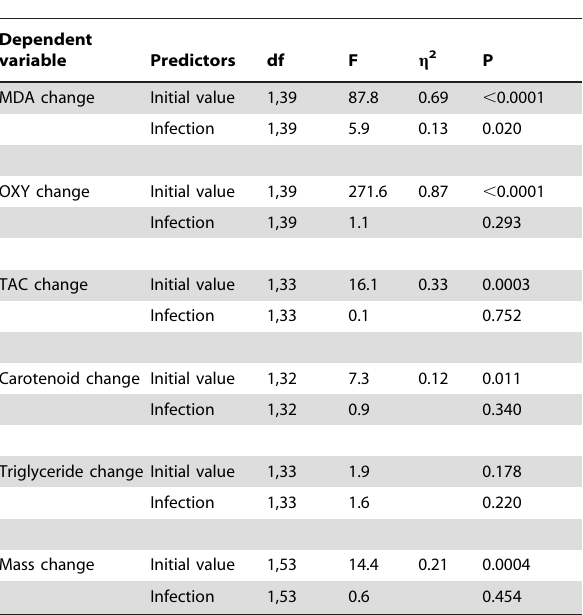
Table 2. Effects of experimental coccidian infection on changes of body mass and biochemical parameters of greenfinches between first and second blood